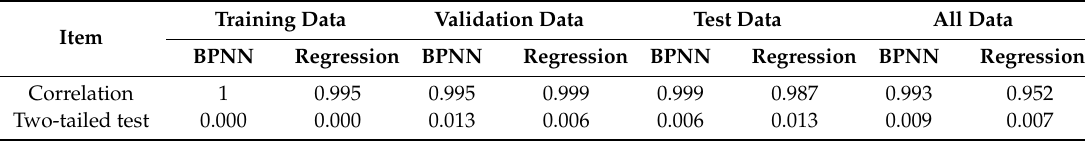
Correlations of the prediction values from the proposed BPNN and those from its regression analysis.